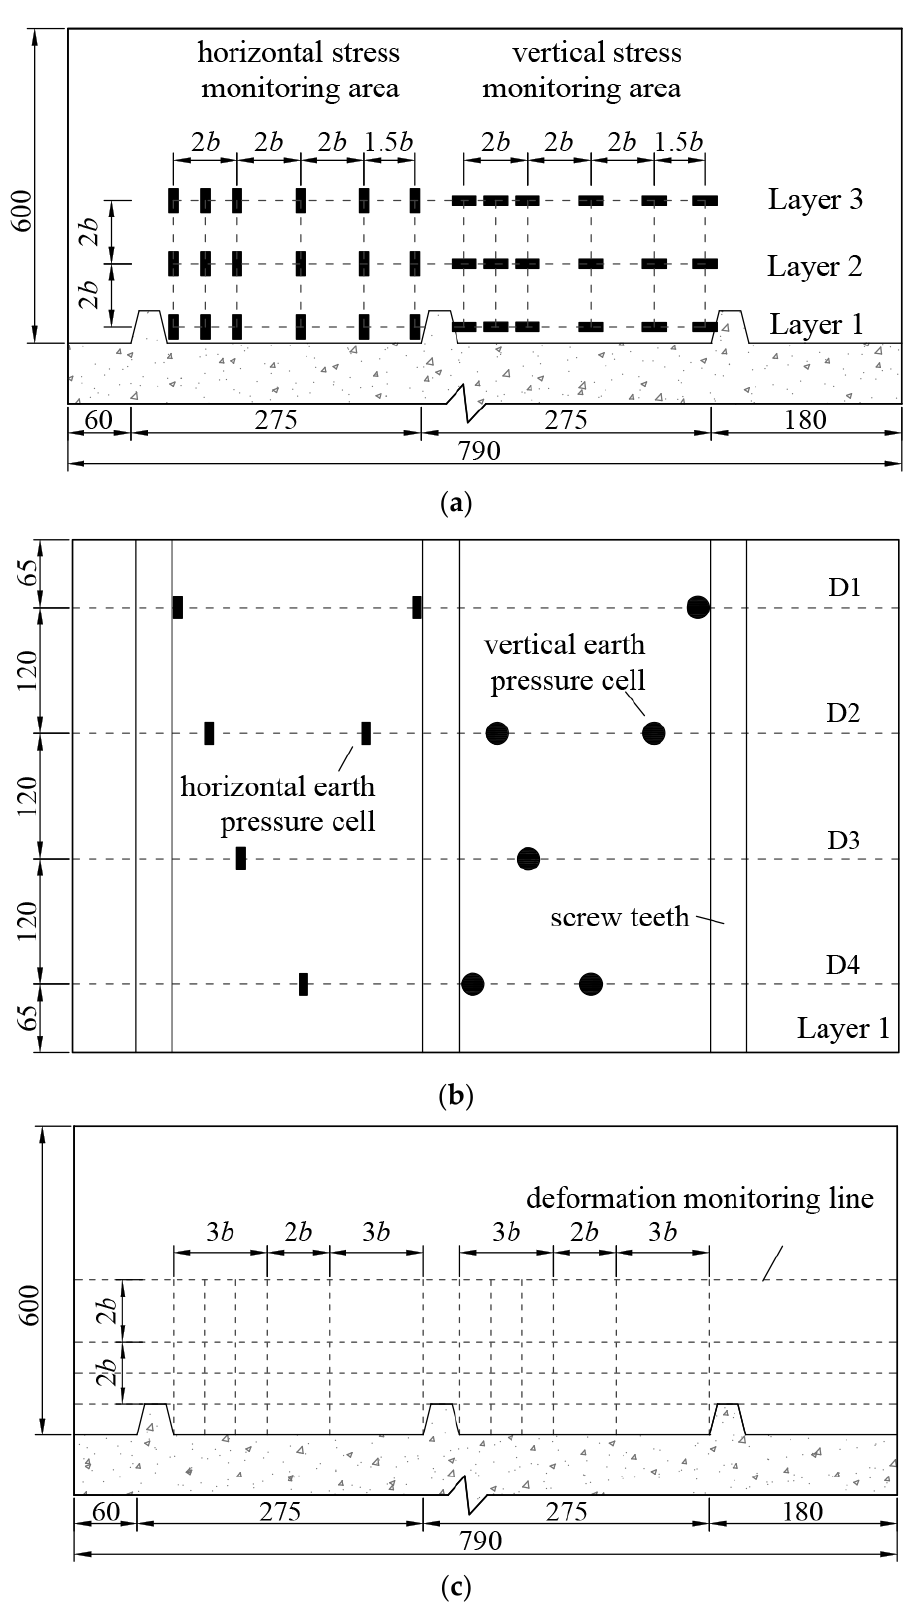
Figure 4. Monitoring arrangement of the 8 b screw shear plate. ( a ) Front view, ( b ) top view of the earth pressure cell of Layer 1, and ( c ) monitoring network of soil deformation.